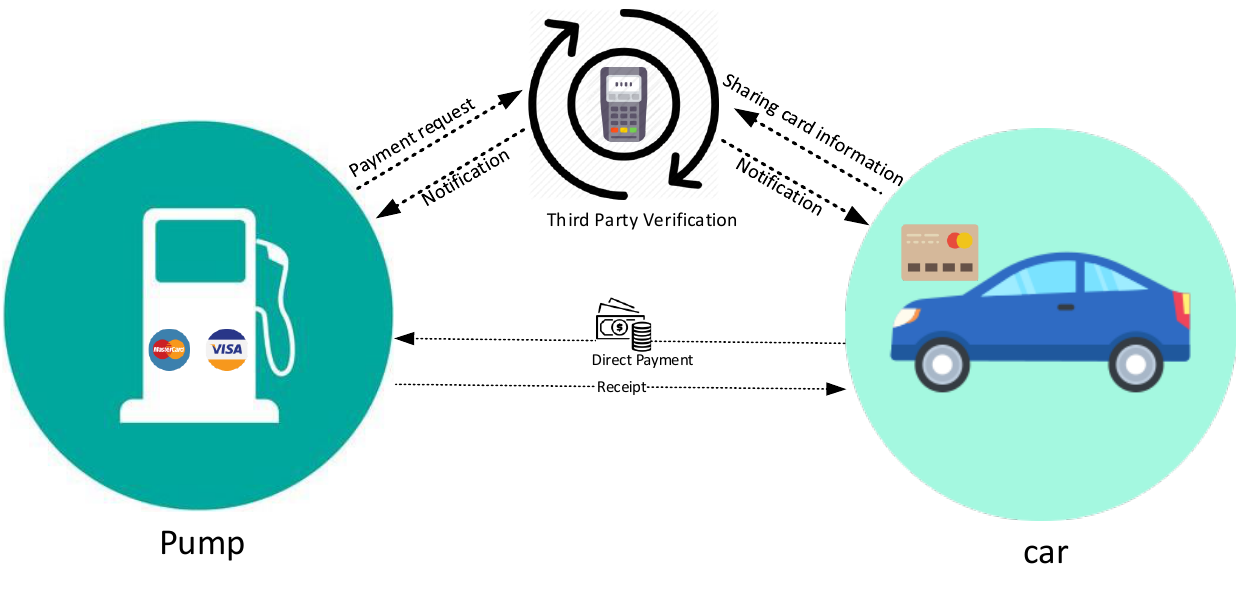
Figure 1. A typical smart pump IoT application which persist user information (e.g., credit